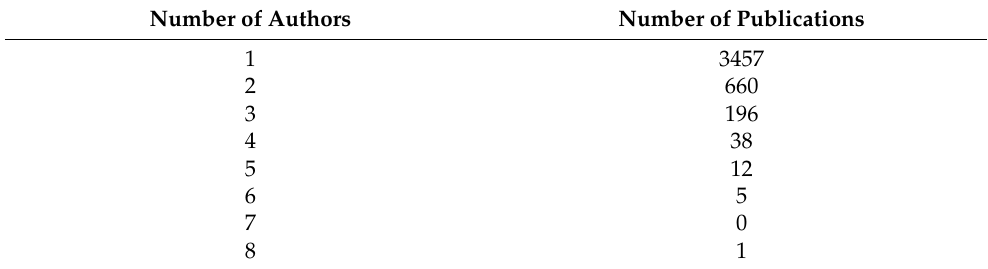
Table 1. Publications with a given amount of authors in the database, after the collection